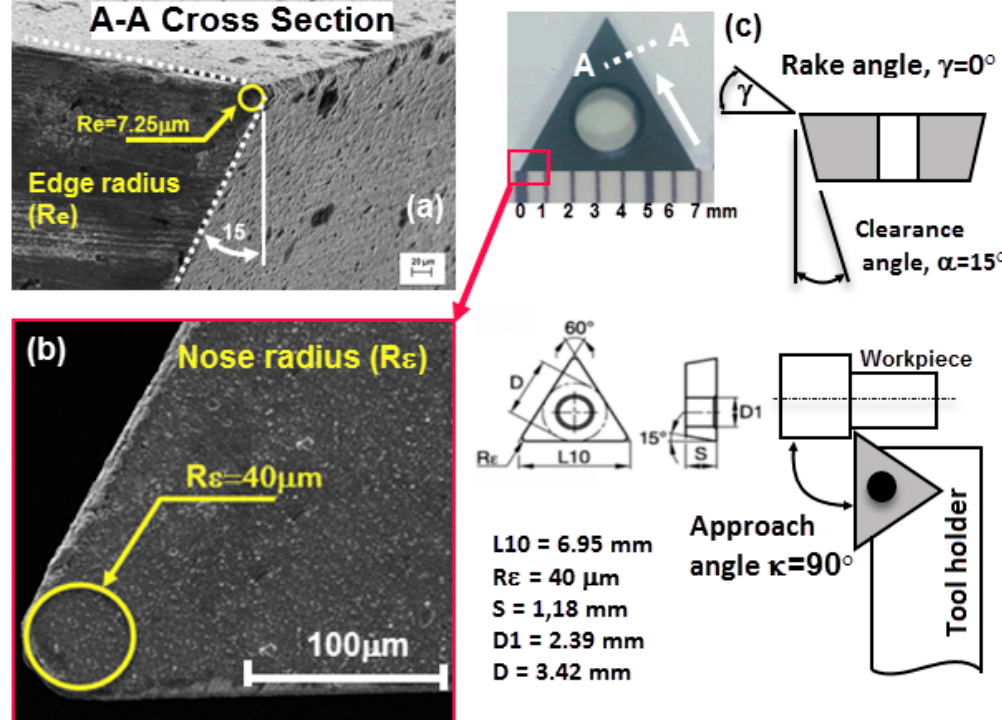
Figure 2. ( a ) Edge radius ( b ) nose radius ( c ) other dimensions of the cutting tool used in micro turning process.